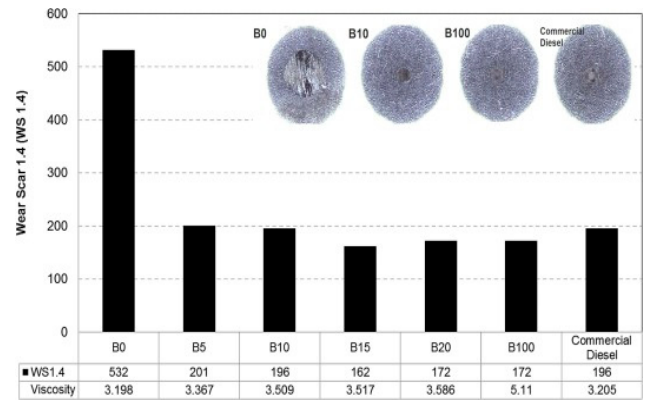
Figure 18. Effect of biodiesel blends on WS1.4 (wear scar 1.4) and viscosity of different concentrations E ff ect of biodiesel blends on WS1.4 (wear scar 1.4) and viscosity of di ff erent [140]. concentrations